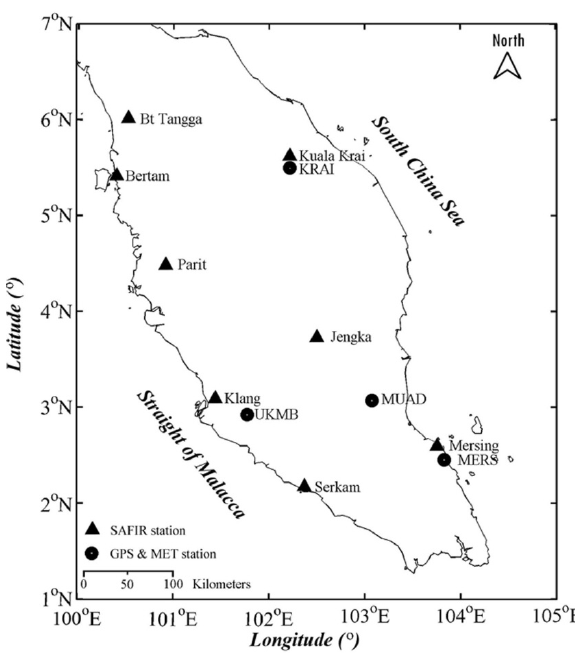
Figure 1. Location of GPS, meteorology and lightning sensors over the Peninsular